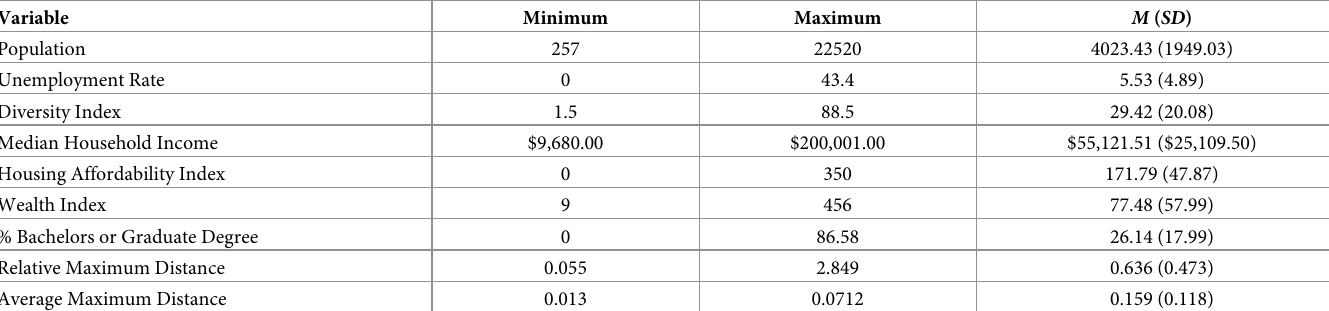
Table 5. Descriptive statistics for demographic and socioeconomic indicators for Ohio tracts (N =